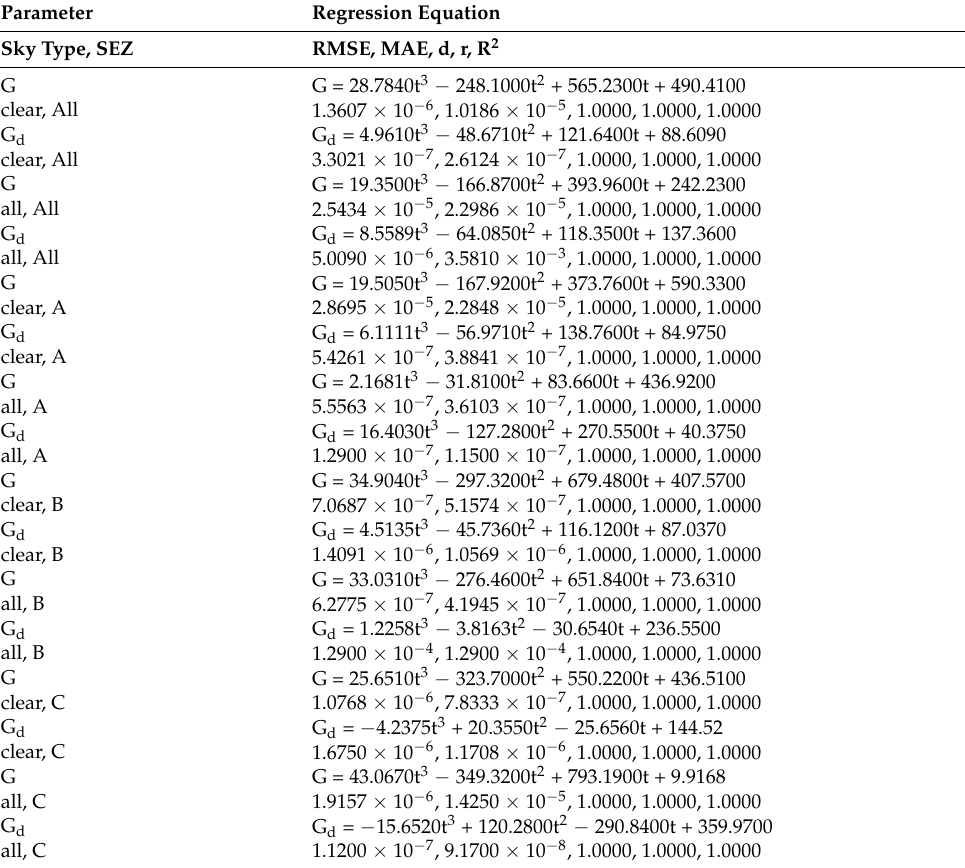
Table 3. Estimation of the seasonal mean values of G (Wm − 2 ) and G d (Wm − 2 ),which are averages over the period 2013–2021 for all 43 sites in SEZ-All, or the sites belonging to the separate zones SEZ-A, SEZ-B, and SEZ-C. t is season (1 = spring, 4 = winter); statistical estimators for the model’s goodness-of-fit: RMSE (Wm − 2 ), MAE (Wm − 2 ), d, r, and R 2 . All statistical results were computed with the MICROSOFT’s Excel 2021